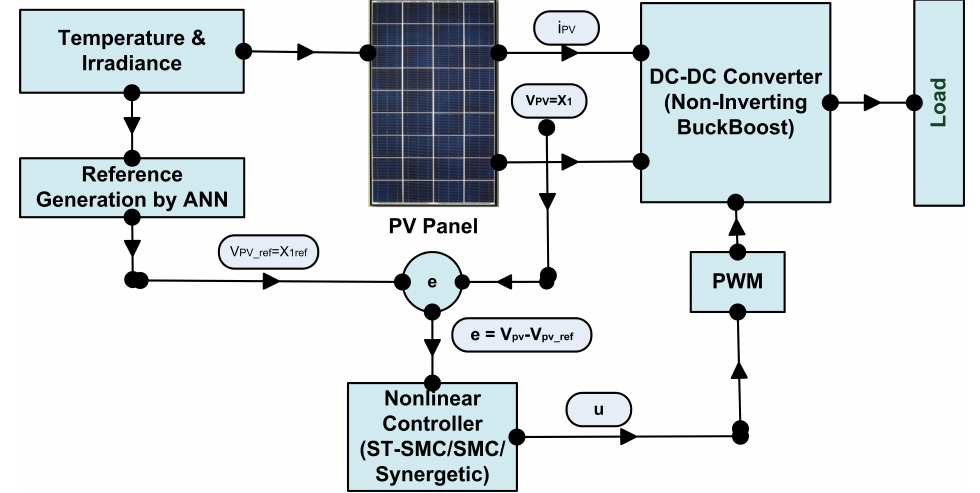
Figure 5. Proposed methodology for maximum power point tracking (MPPT) control of a PV system. Reference Voltage Generation by